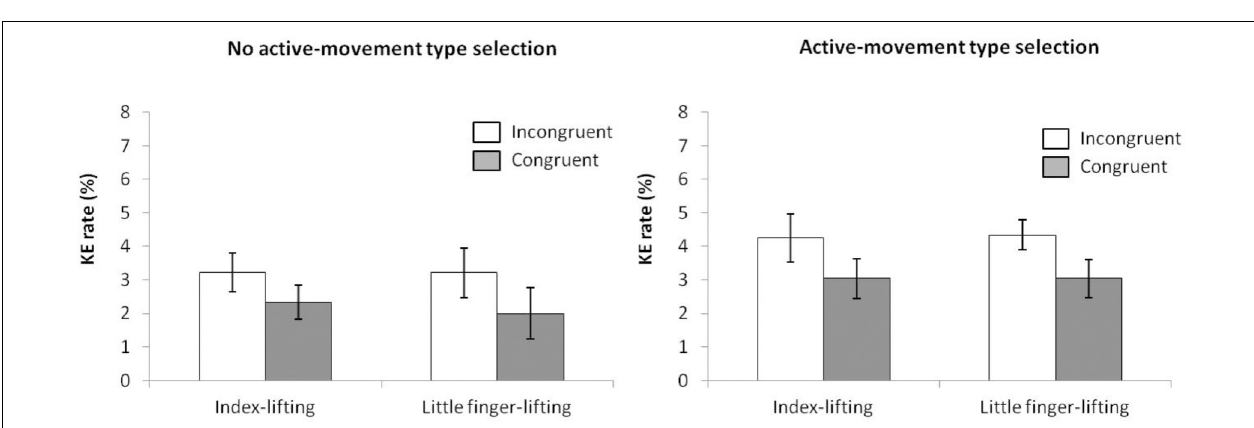
FIGURE 12 | Interactions of movement × congruence within the no active-movement type selection condition (Left) and active-movement type selection (Right) , with respect to rate of kinematic errors in Experiment 4. Error bars represent the standard error of the mean.